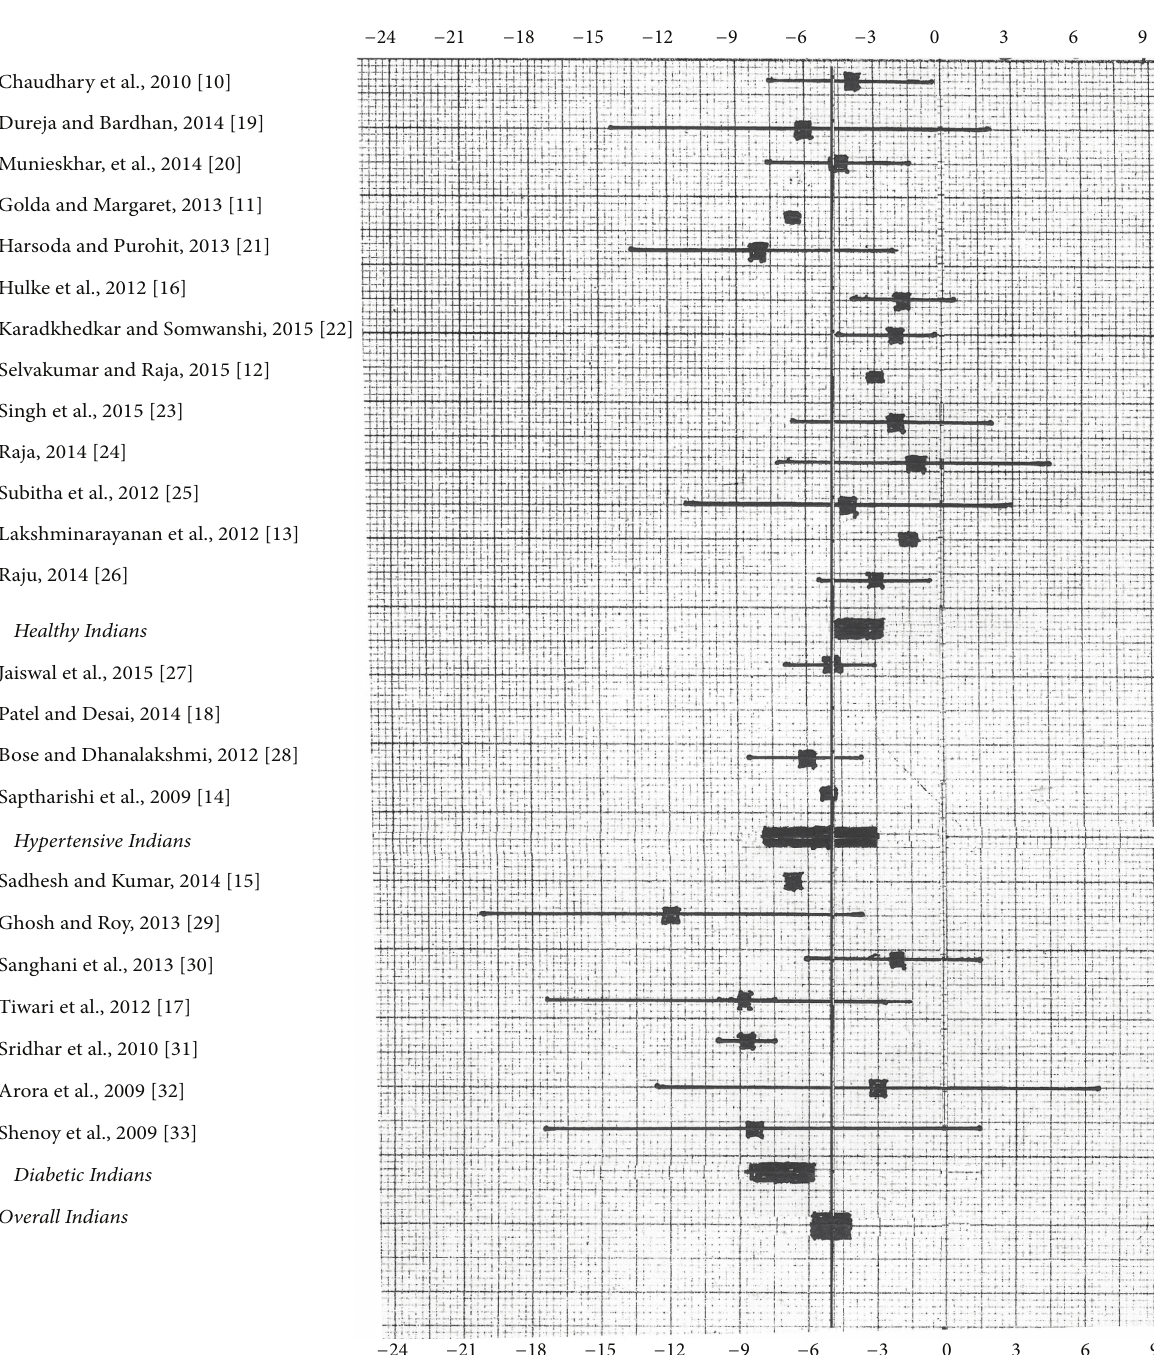
Hypertension is a growing problem in India with every third to fifth Indian as hypertensive [2, 37, 38]. Approximately 10% of death in India was attributable to high blood pressure [39]. It is the third leading risk factor for disease burden in both developed and developing nations worldwide